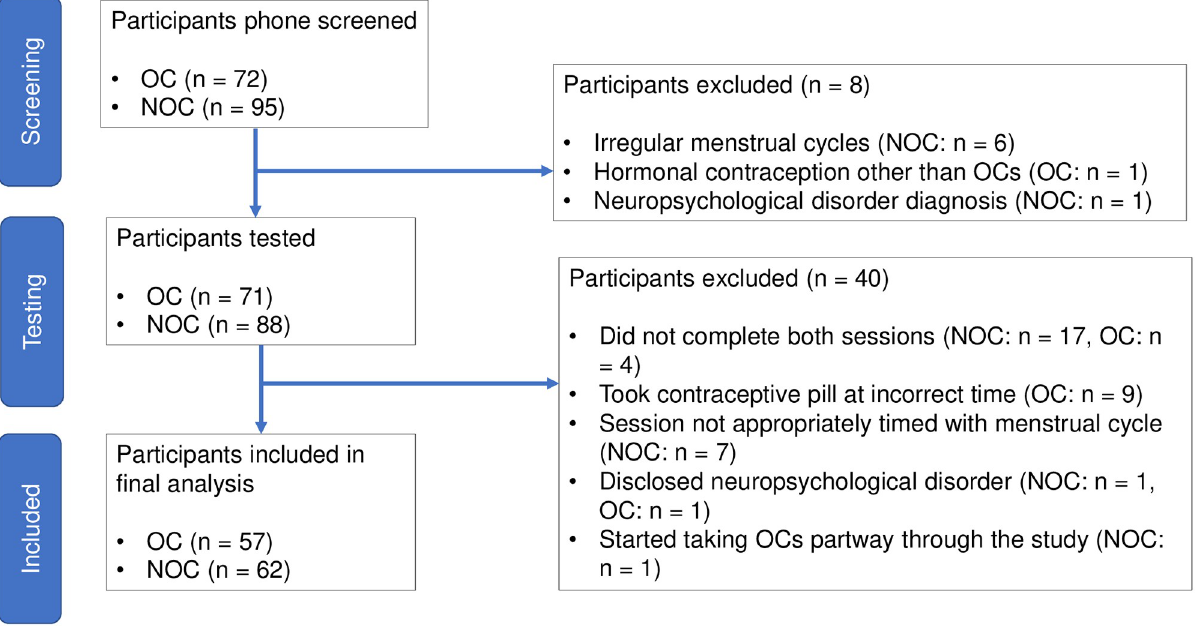
Fig 2. Flow diagram of the participant exclusion